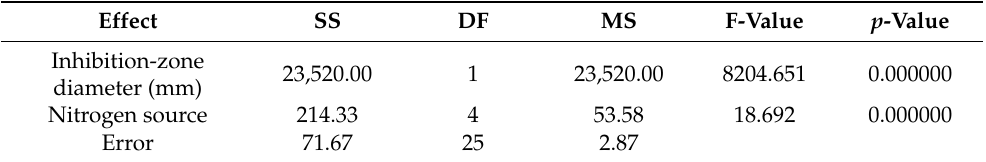
Table 4. One-way ANOVA of inhibition-zone diameter obtained by testing antagonistic activ- ity of cultivation broth samples against the aflatoxigenic isolates in the nitrogen source selection investigation